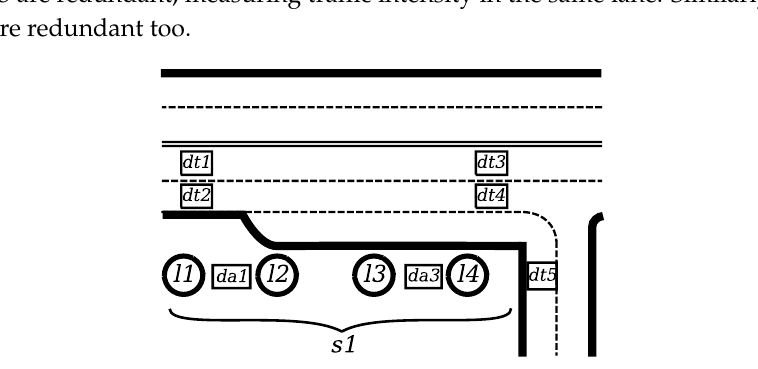
Figure 3. A real world example of a street segment s 1, with luminaires l 1, . . . , l 4, and multiple traffic intensity detectors dt 1, . . . , dt 5 and ambient light detectors da 1, da